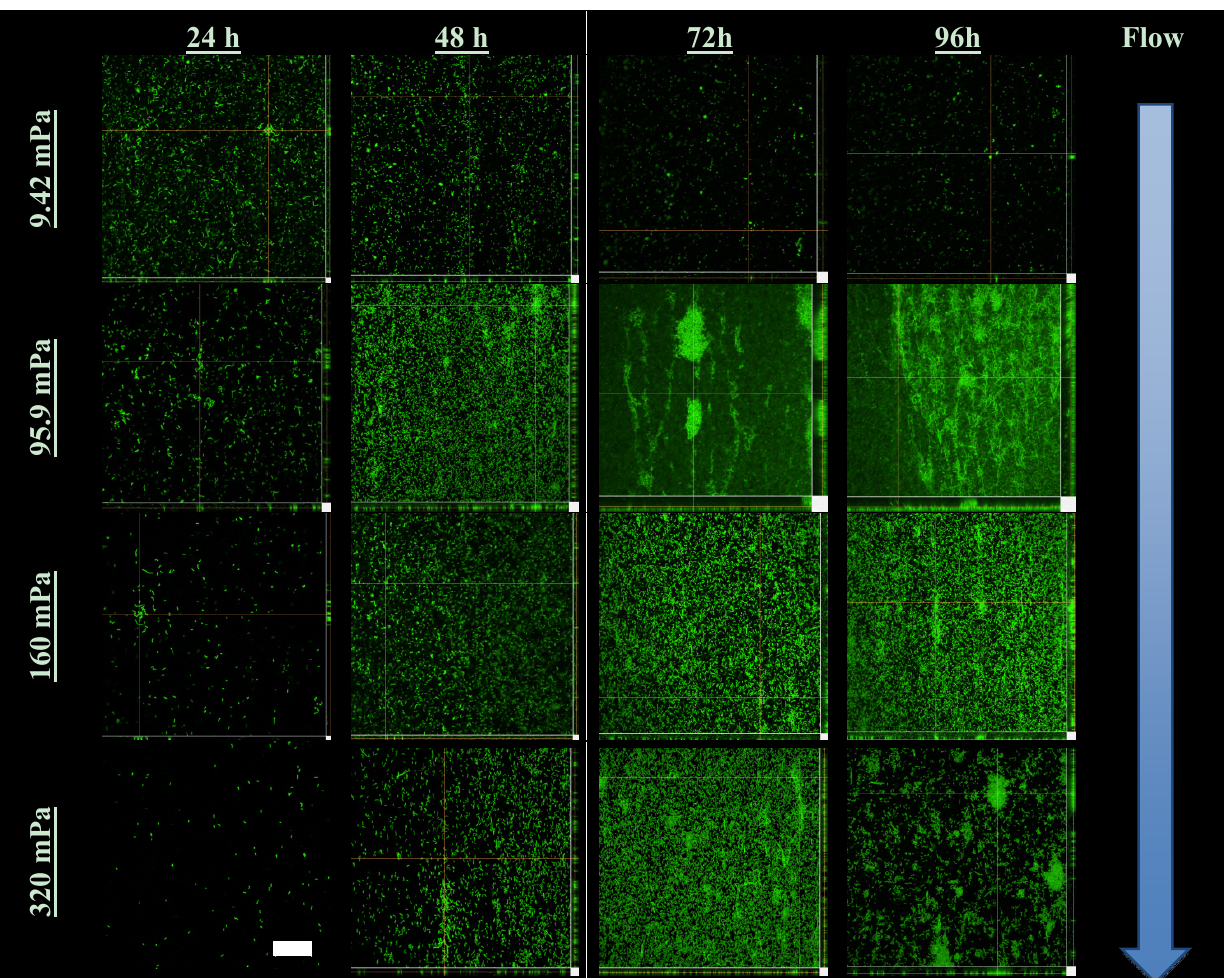
Figure 3. Representative CLSM orthogonal projections of stacks of images taken of the various biofilms at 0.6 μ m depth intervals. The main part of each image consists of a single 2D slice of the biofilm ( xy -direction) whereas the smaller side panels below ( xz- direction) and to the right ( yz- direction) indicate a digital projection of the depth of biofilm biomass from the attachment surface to the bulk-liquid interface. A scale bar indicating 50 μ m is included in the bottom left